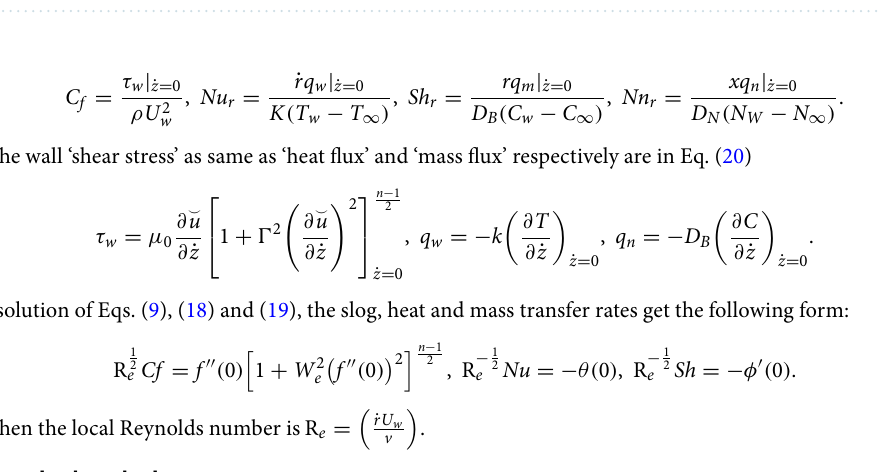
Figure 2. Flow chart of numerical scheme